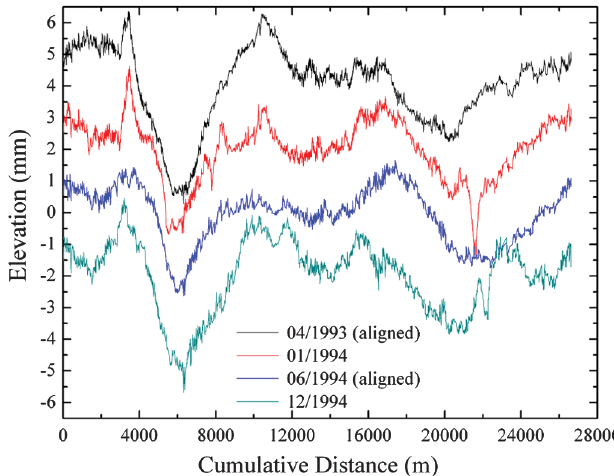
FIG. 13. (Color) Elevations of the CERN’s LEP focusing mag- nets measured in 1993–1994 [26] vs cumulative distance along the ring (i.e., the point at 0 m placed close to the point at 26.7 km, data courtesy of Jean-Pierre Quesnel of the CERN’s Survey